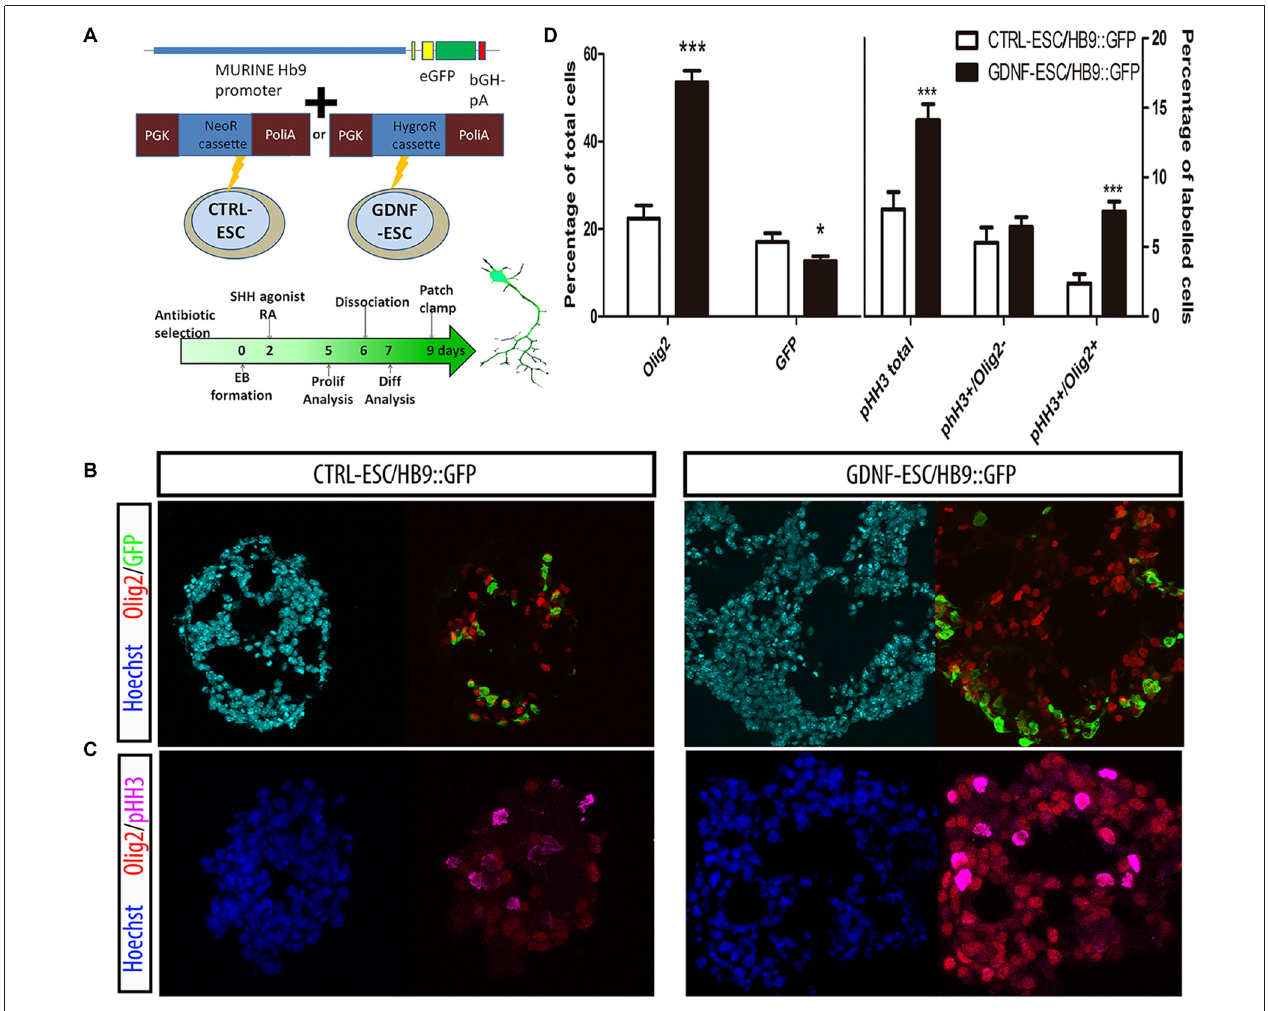
FIGURE 2 | GDNF overexpression increases the proliferation and enhances terminal differentiation to Motor neuron (MN). (A) Scheme of the Hb9::GFP constructs inserted into CTRL- and GDNF-ESC, conferring neomycin or hygromycin B resistance, respectively, and timeline of experiments. (B) Representative micrographs of day 5 EBs stained to identify MN precursors (pMN; Olig2+) and MNs (GFP+). (C) Day 5 EBs were labeled with antibodies against Olig2 and phospho-histone H3 (pHH3), in both CTRL- and GDNF-ESC/HB9::GFP. (D) Quantification of experiments shown in Figure 4B (left side) and Figure 4C (right side). ∗ p < 0.05 and ∗∗∗ p < 0.0001 vs. CTRL-ESC/HB9::GFP. Data from four experiments in